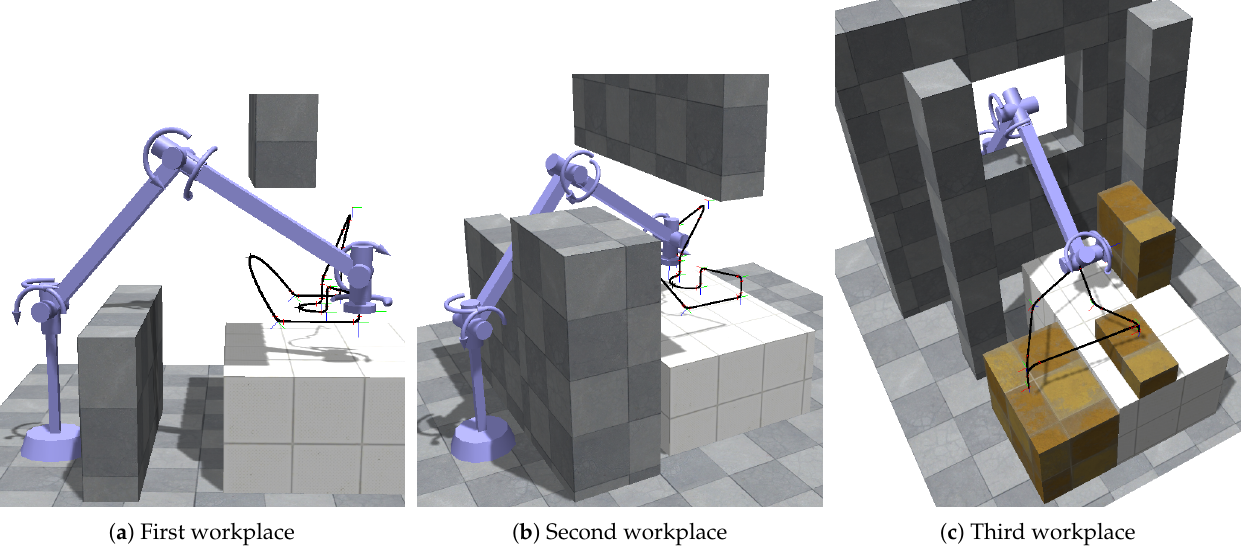
Figure 9. Three simplified testing workplaces with the robot in collisions in the initial state. ( a ) Simple obstacles in front of the robot and above the robot. ( b ) More obstacles with less space between them. ( c ) A confined workplace with the robot behind a rectangular opening in the